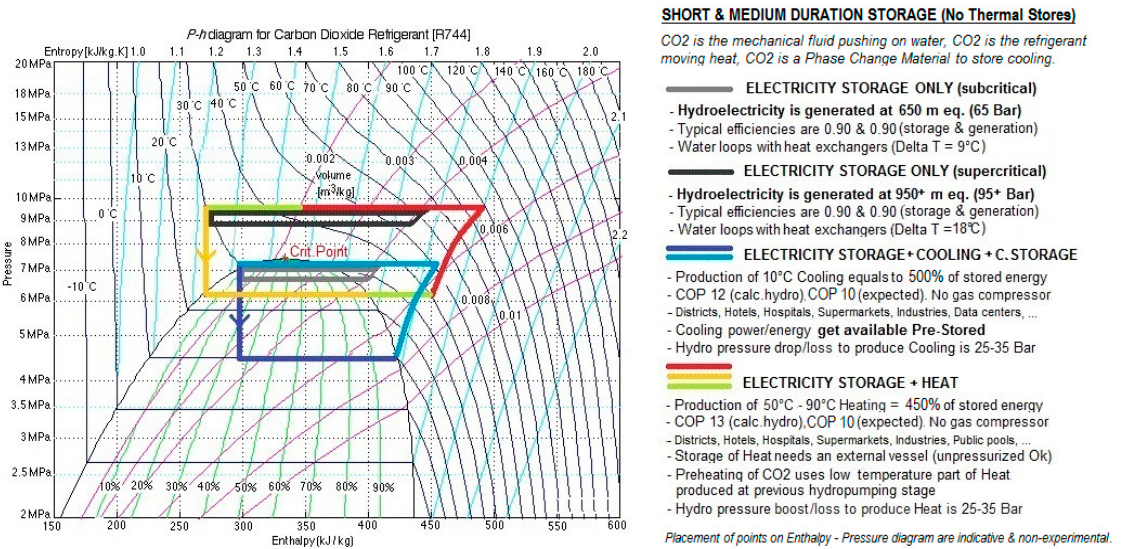
Figure 4. Di ff erent applications of the novel system, for storage of short and medium durations, illustrated on the Enthalpy–Pressure diagram related to CO 2 .